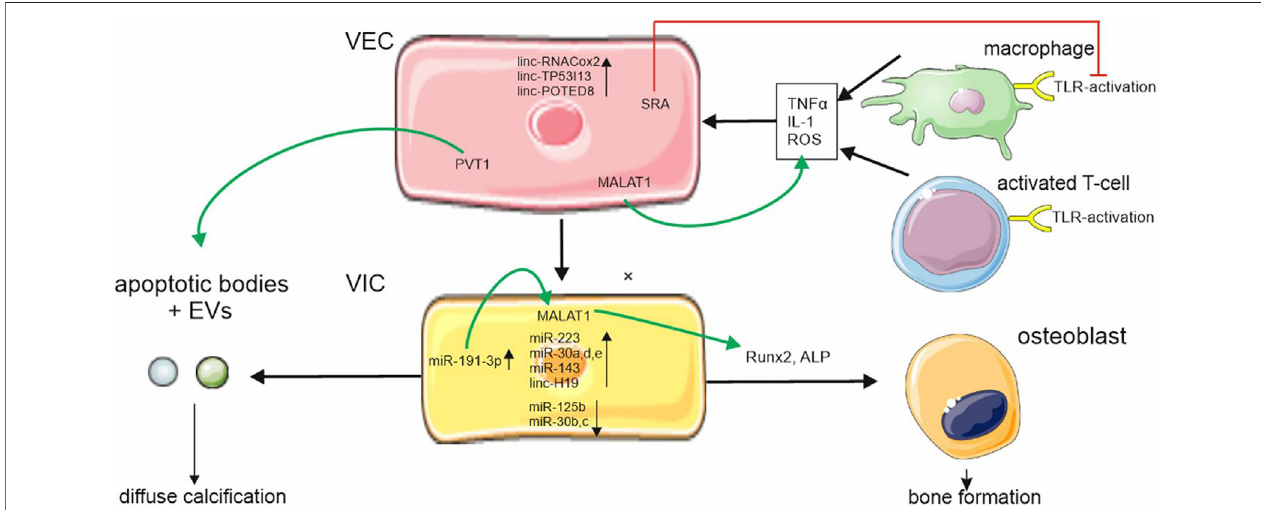
FIGURE1| ncRNAregulationinaorticstenosis.ncRNAsaredifferentlyexpressed duringaorticstenosis disease progressioninvalvular endothelial cells(VEC)and valvular interstitial cells (VIC). Metastasis associated lung adenocarcinoma transcript 1 (MALAT1) is upregulated in VECs und VICs and increases pro-in fl ammatory cytokineexpressionandregulatorsofosteoblasticdifferentiation.Plasmacytomavarianttranslocation(PVT1)regulatesapoptosis.Apoptosisispartofacomplexsystem leading to programmed cell death thus causing increased calcium uptake of VICs through cell debris steroid receptor RNA activator (SRA) which downregulates Toll-like receptor (TLR) activation. Cellular symbols were adopted with permission from smart.servier.com and